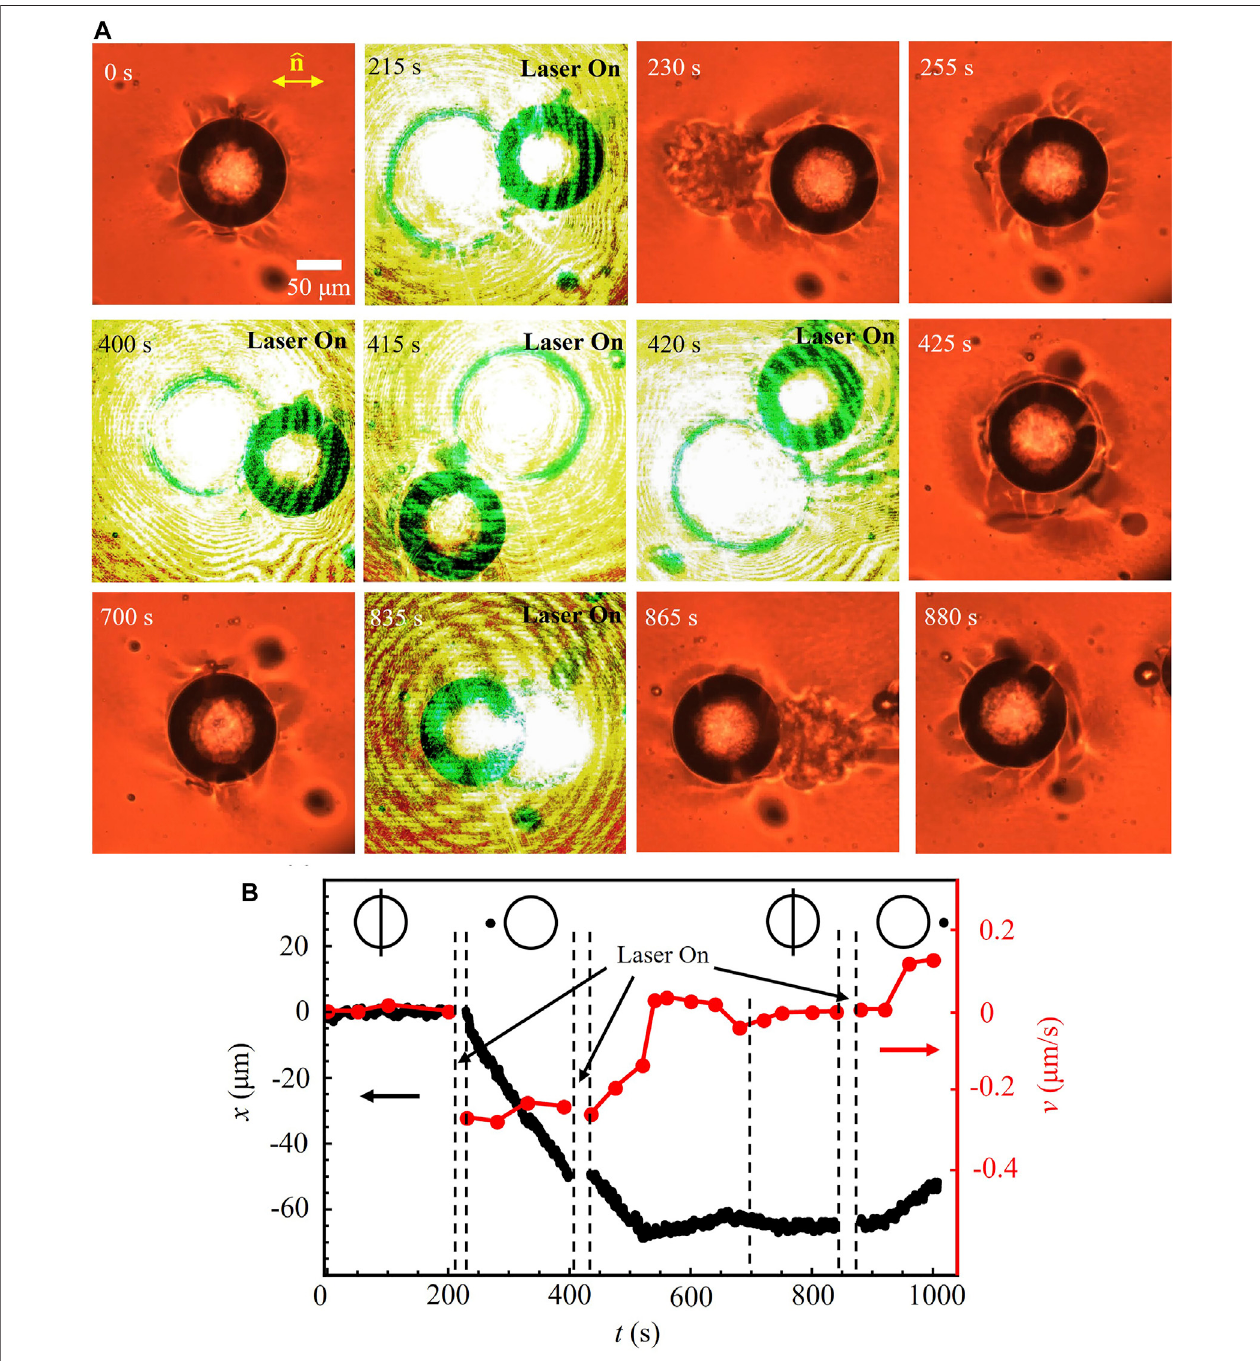
FIGURE 6 | Control of speed and polarity ofdroplet propulsion by light. (A) A stationary active droplet with an SR director con fi guration. A laser beam is pointed to the left side of the droplet and forms an HH on that side. Then, the laser is moved around the droplet at a distance of about 2 R − 3 R from the drop ’ s center to melt the surrounding nematic. When the beam is switched off, the nematic recovers and produces an SR around the droplet. Next, the laser beam is pointed to the right side of thedropletandformsHHonthatsideandthusreversesthepolarityofmotion. (B) Thedisplacement x andspeed v oftheactivedropletalongtheoveralldirectorof 5CB as functions of time. The droplet with an SR does not propel. After laser beam irradiation and the formation of the HH on the left side, the droplet moves to the left. ThelasertransformsHHtoSR.Duringthetransformation time(425-700 s)thedroplettrajectory fl uctuates.WhentheSRformsthedropletshowsnopropulsion.Finally, the laser is pointed to the right side of the droplet and forms the HH there; the HH leads the droplet to propel to the right.